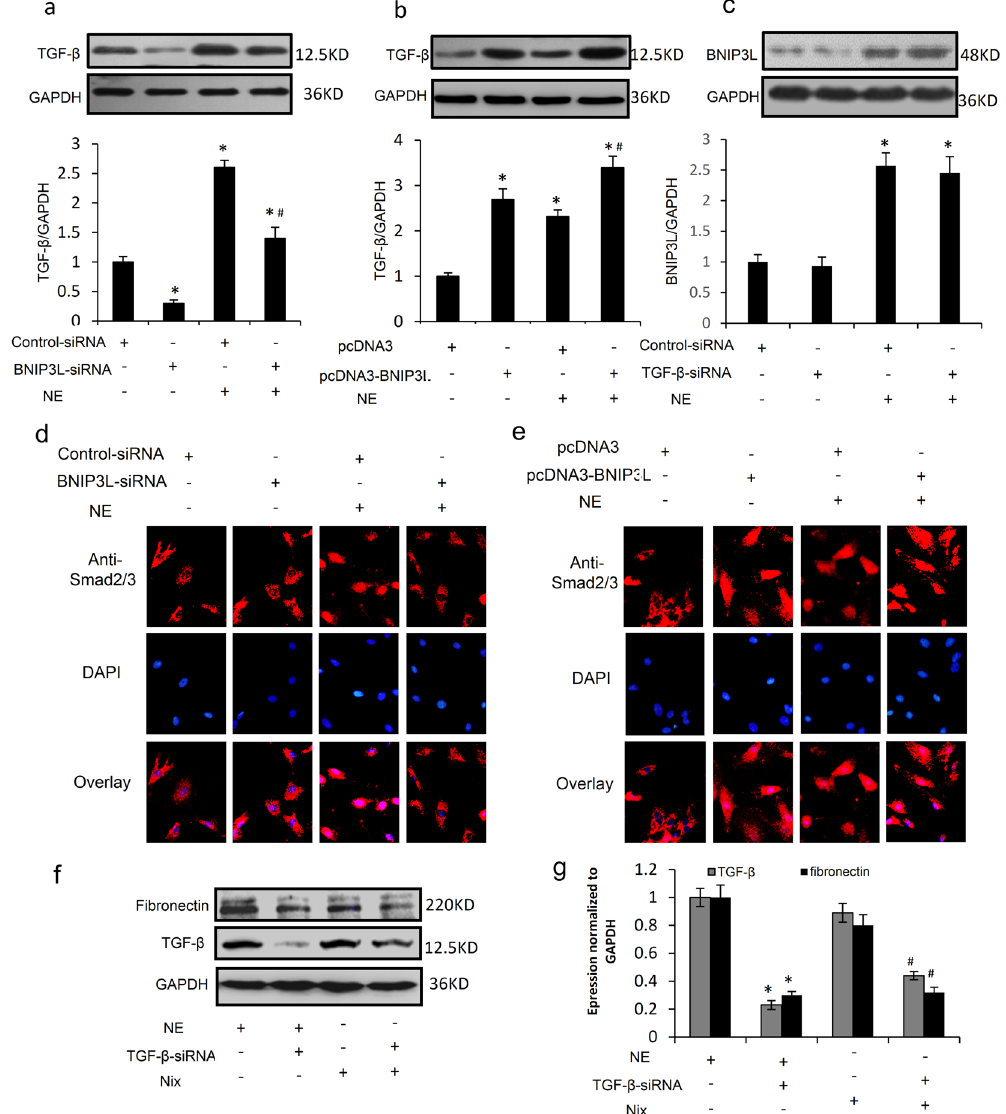
Figure 6. BNIP3L plays an important role in fibrosis via the TGF- β /Smad signaling pathway. Neonatal rat CFs were transfected with the BNIP3L and BNIP3L-siRNA adenoviruses or were treated with NE after the transfection. ( a,b ) Western blot analysis showing the effects of the adenoviruses on the expression of TGF- β ( * P < 0.05 vs. Control, # P < 0.05 vs. NE). ( c ) Western blot analysis showing the effects of TGF- β -siRNA on the expression of BNIP3L. ( d,e ) Immunofluorescence images demonstrating the nuclear accumulation of Smad2/3. ( f,i ) Western blot analysis showing the effects of NE, pcDNA3-BNIP3L and TGF- β -siRNA on the TGF- β and fibronectin protein levels ( * P < 0.05 vs. NE, # P < 0.05 vs. BNIP3L). Each experiment repeated three